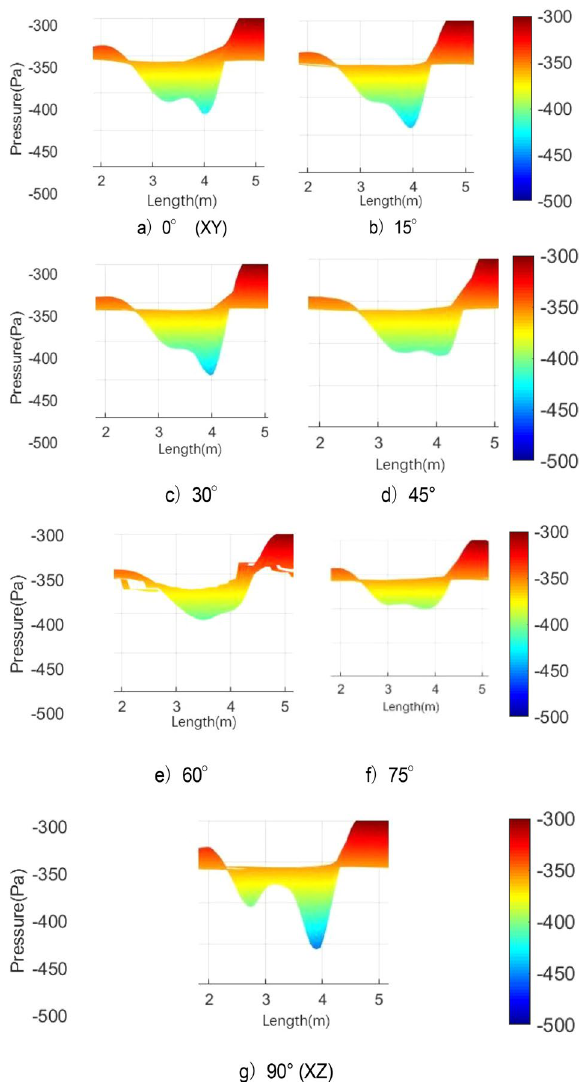
Figure 28. Pressure cloud diagram on different sections at t